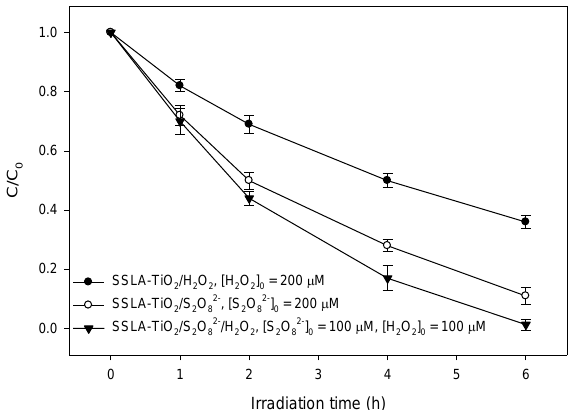
Figure 3. E ff ect of S 2 O 82 − and H 2 O 2 additives on the simulated solar light-activated TiO 2 photocatalysis Figure 3. Effect of S 2 O 82− and H 2 O 2 additives on the simulated solar light-activated TiO 2 of lindane. [lindane] 0 = 1.0 µ M; [S 2 O 82 − ] 0 = [H 2 O 2 ] 0 = 200 µ M; mass of TiO 2 film = 9.02 mg; thickness photocatalysis of lindane. [lindane] 0 = 1.0 µM; [S 2 O 82− ] 0 = [H 2 O 2 ] 0 = 200 µM; mass of TiO 2 film = 9.02 of TiO 2 film = 1.02 µ m; area of TiO 2 film = 3750 mm 2 ; pH = 5.8. mg; thickness of TiO 2 film = 1.02 µm; area of TiO 2 film = 3750 mm 2 ; pH = 5.8.